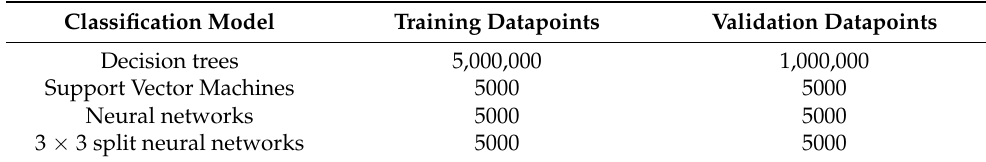
Table 6. Training, testing, and validation